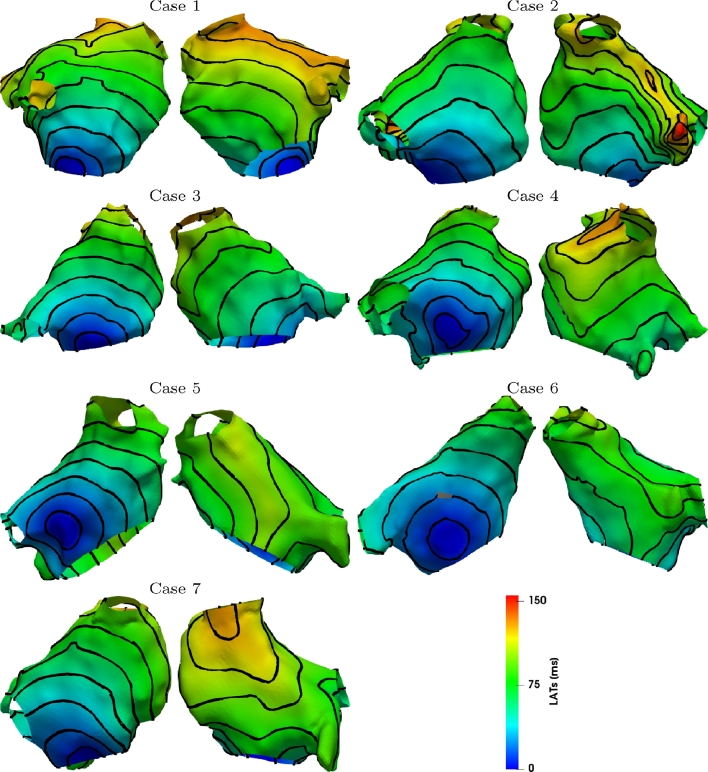
LATs evaluated by numerical simulations when s2=343ms and stimulus is applied in the CS. Isochrones are equally spaced with 10 ms intervals.